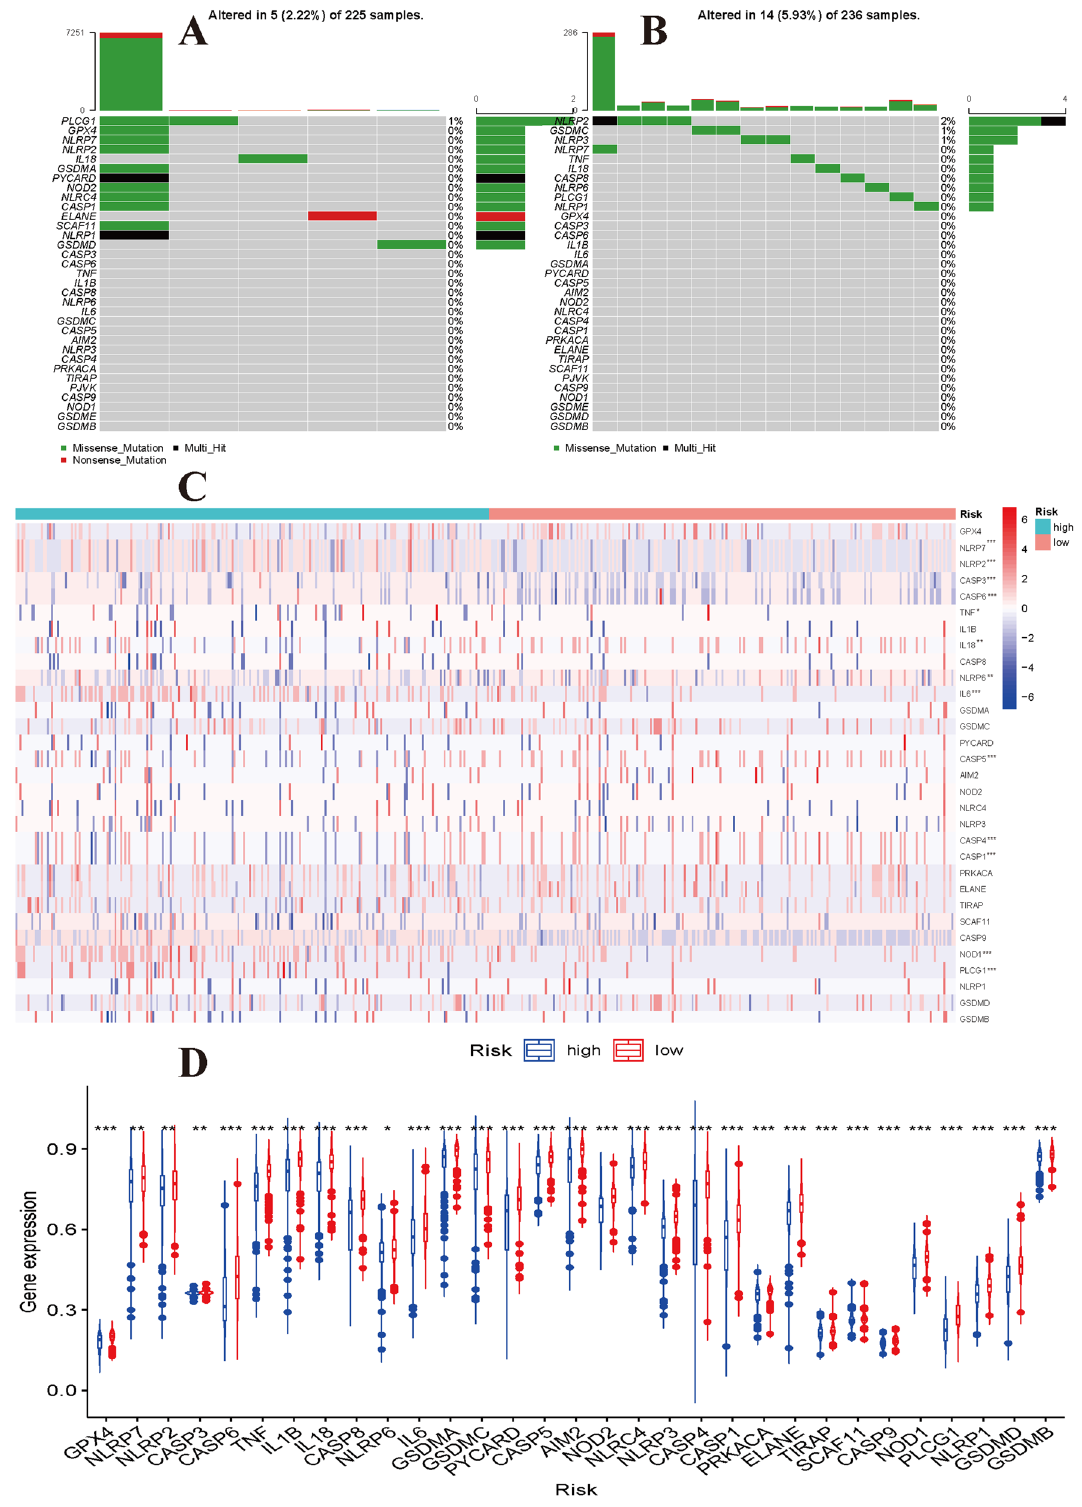
Figure 7. Molecular alterations of pyroptosis genes in TCGA dataset. ( A ) The mutations frequencies in low- risk group and ( B ) in high-risk group. ( C ) Somatic copy number differences between high- and low-risk groups. ( D ) The differential expression levels of DNA methylation between high- and low-risk